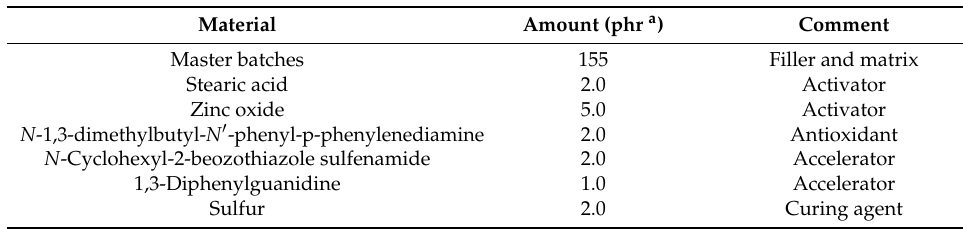
Table 2. Formulation of silica/natural rubber (NR)